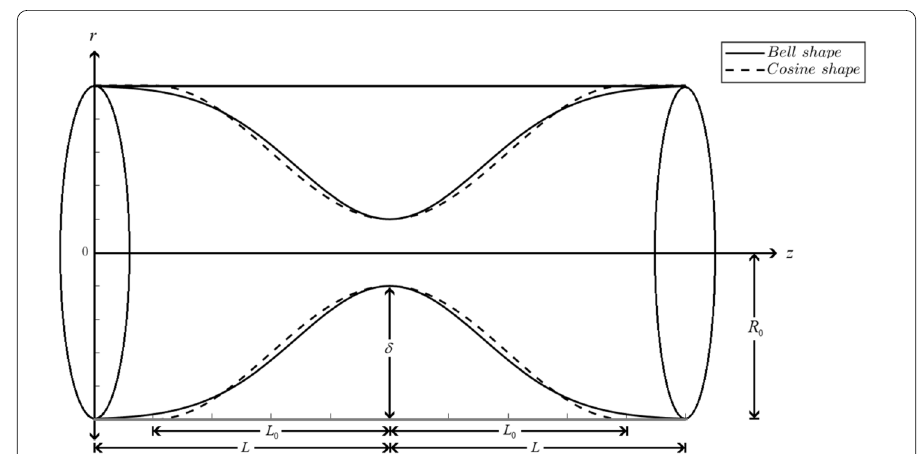
Figure 1 Geometry of stenosed artery with bell shape and cosine shape